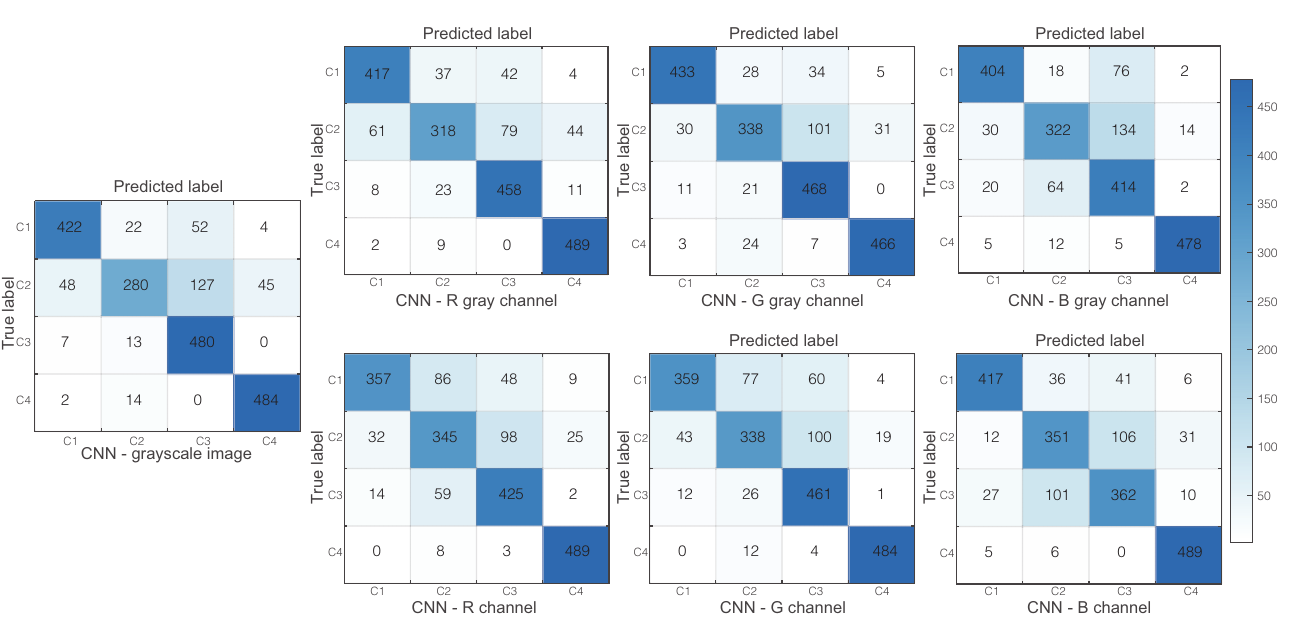
Figure 4. Confusion matrix for each trained model using: weighted linear combination grayscale images, red channel grayscale images, green channel grayscale images, blue channel grayscale images, 3-channel images with the non-zero red channel, 3-channel images with the non-zero green channel, 3-channel images with the non-zero blue channel. C1: normal, C2: chronic otitis media, C3: otitis media with effusion, and C4: earwax